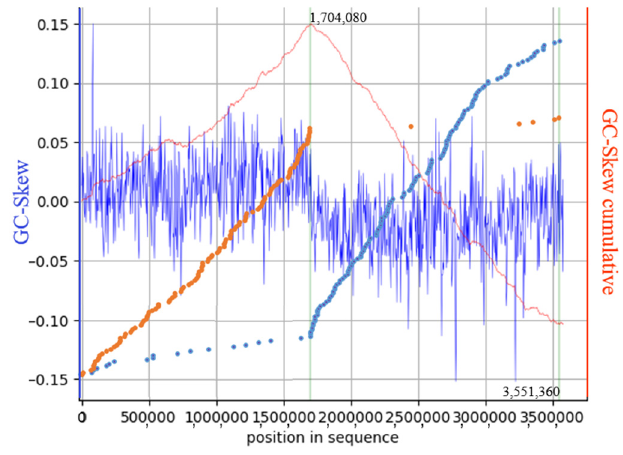
Figure 3. Distribution of non-coding 8-base motif and GC-skew on L6-AK89 chromosome. Dark